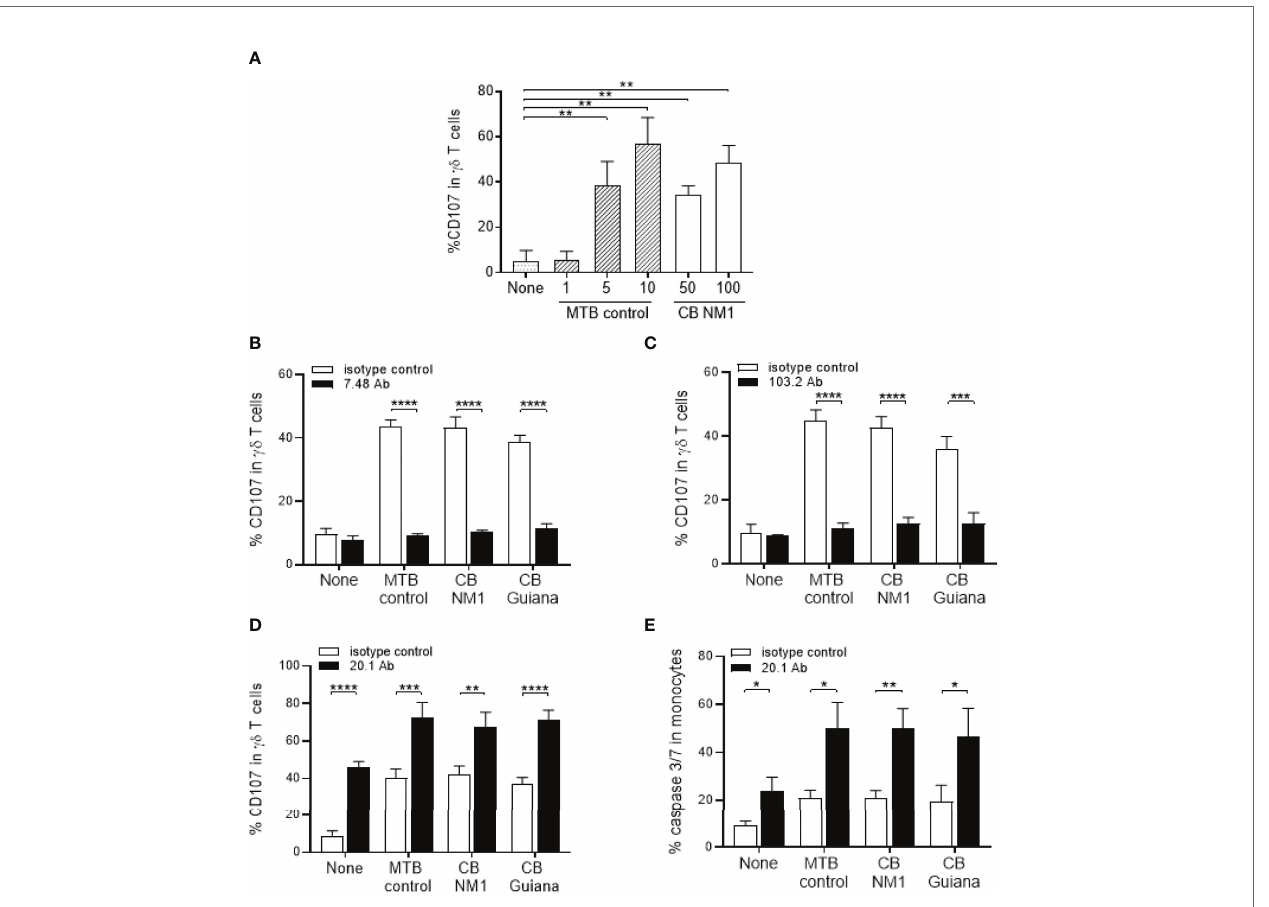
FIGURE 4 | Infection with C. burnetii leads BTN3A and BTN2-dependent activation of V g 9V d 2 T lymphocytes. (A) Monocytes isolated from healthy donors (n = 3) previously infected 24 hours with C. burnetii NM1 (50 or 100 MOI) or with M. tuberculosis (1, 5 or 10 MOI) were co-cultured with autologous V g 9V d 2 T cells (E:T ratio of 1:1). V g 9V d 2 T cell degranulation (%CD107ab+ cells) was assessed after 4 hours of co-culture by fl ow cytometry. (B – D) Monocytes isolated from healthy donors (n = 4) previously infected 24 hours with ( C ) burnetii strains (50 MOI) or with M. tuberculosis (5 MOI) were co-cultured with V g 9V d 2 T cells expanded from healthy donor (E:T ratio of 1:1) in the presence of (B) anti-BTN2A (clone 7.48), (C) anti-BTN3A (clone 103.2) or (D) anti-BTN3A (clone 20.1) antibodies (10µg/ml). V g 9V d 2 T cell degranulation (%CD107ab+ cells) was assessed after 4 hours of co-culture by fl ow cytometry. (E) The cytotoxicity was assessed by fl ow cytometry as the percentage of Caspase 3/7 + cells in the target cell population after 4 hours of co-culture in presence of anti-BTN3A antibody (clone 20.1) (10µg/ml). Data were analyzed using a normality test and a parametric t test. Values represent mean ± standard deviation. * p < 0.05 , ** p < 0.01 , *** p < 0.001 and **** p < 0.0001